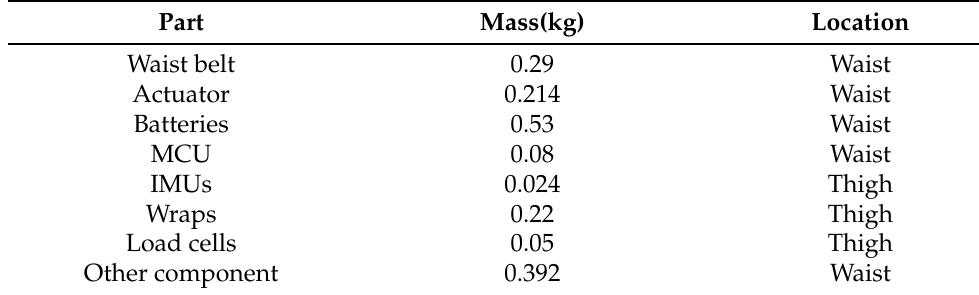
Table 1. The mass distribution of the lightweight soft exosuit.